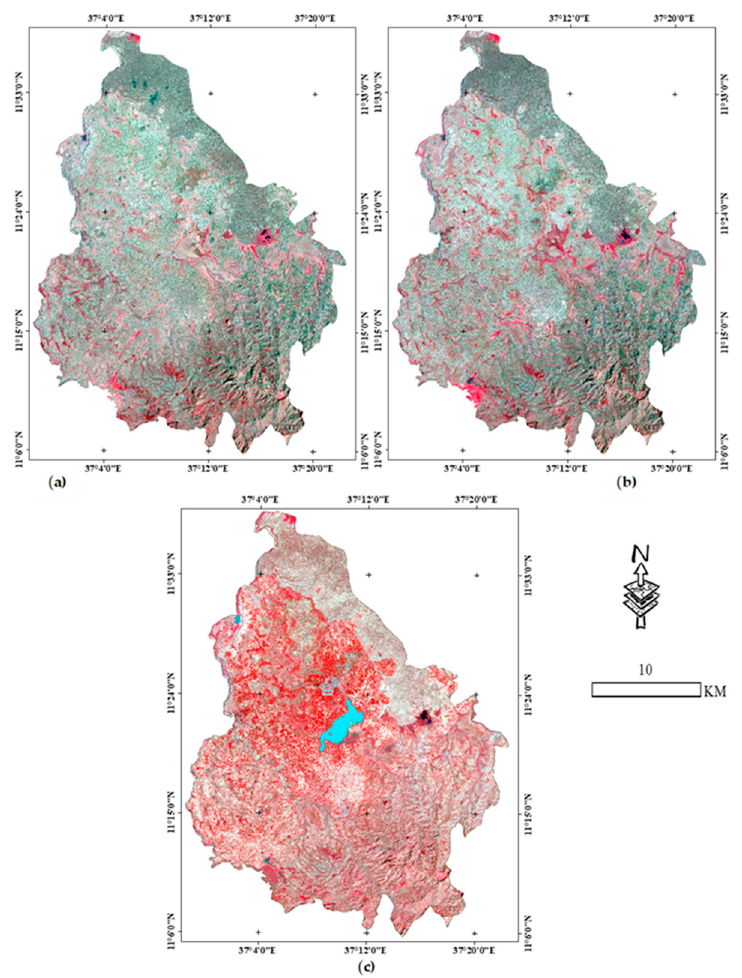
Figure 3. Landsat image False Color Composite of the study area ( a ) 1991, ( b ) 2006 and ( c ) 2021.